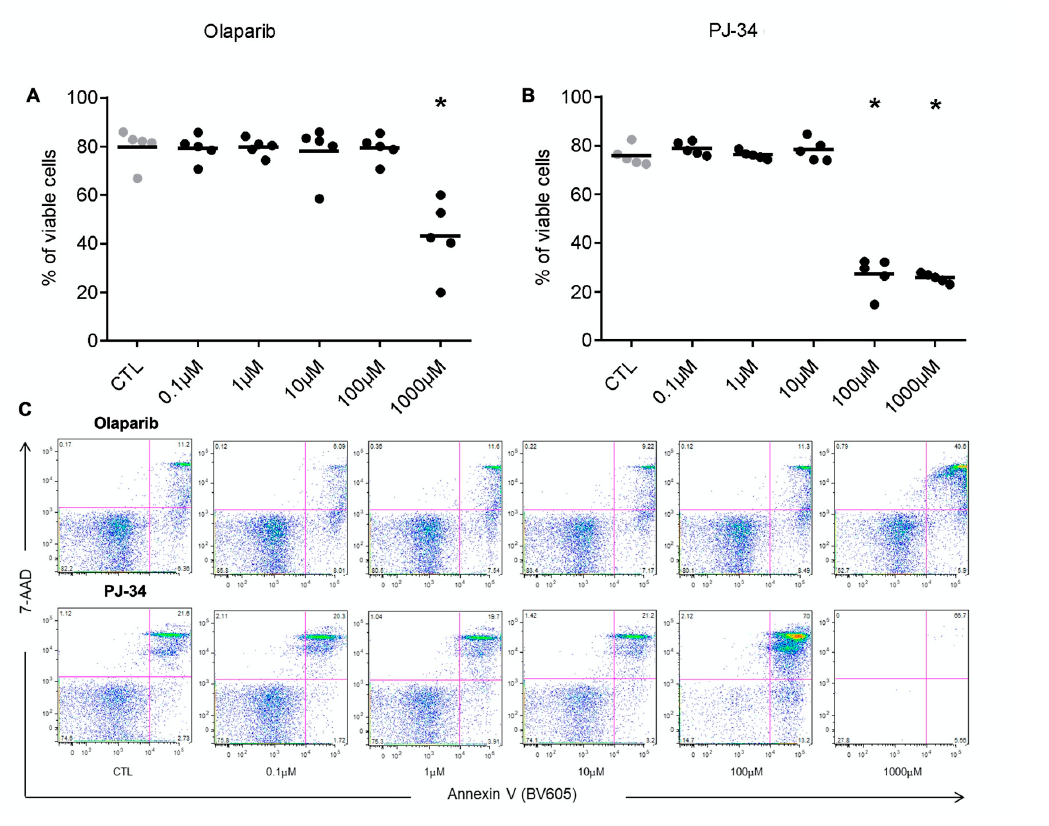
Figure 1. Effect of olaparib and PJ-34 on PBMC viability. ( A , B ) Analysis of cell viability in PBMCs from five healthy individuals at different concentrations of olaparib and PJ-34 (0.1–1000 µM). ( C ) Representative dot plots. Phosphatidylserine externalization was detected via Annexin V staining, and a change in cell membrane integrity (resulting in increased 7-ADD dye uptake) was detected via 7-ADD staining. “Viable cells” in ( A , B ) are defined as the portion of cells that were negative for both Annexin and 7-ADD. * p < 0.01 shows significant decrease in cell viability compared to the control (ANOVA followed by Tukey’s